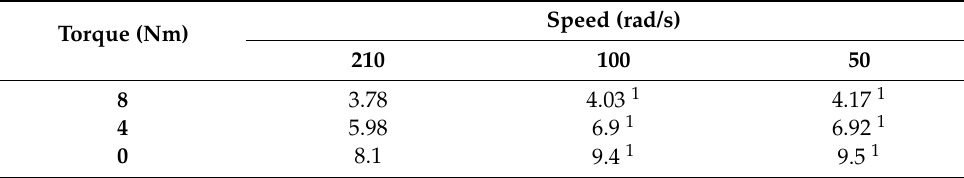
Table 7. Measured THD (%) for conventional